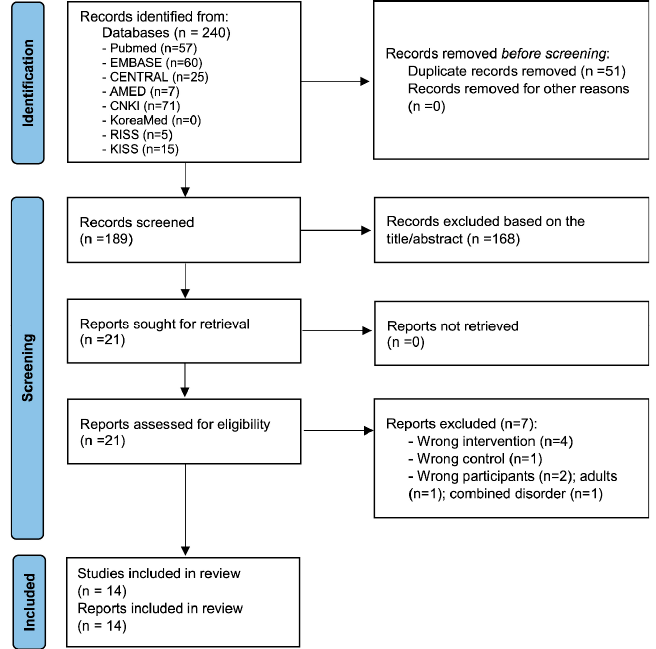
Figure 1. Study selection flow diagram.